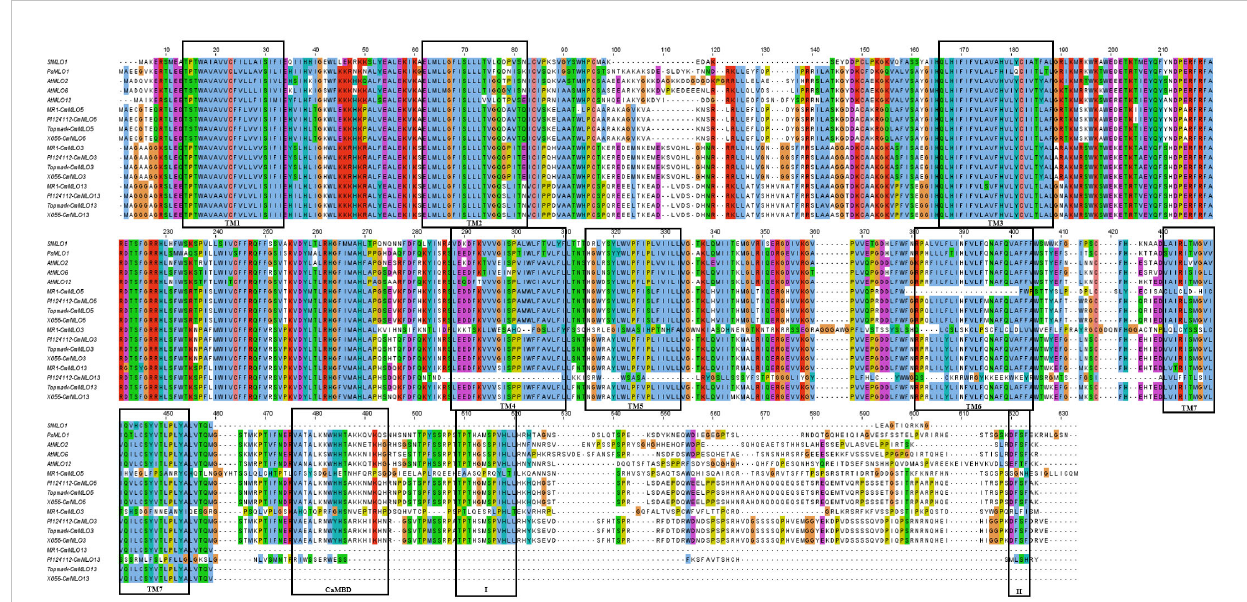
FIGURE 7 Multi-sequence comparison between the CmMLO protein in Clade III and powdery mildew susceptible MLO proteins in PsMLO1, SIMLO1, along with AtMLO2, 6, and 12. TM1 – TM7 is representing seven MLO protein transmembrane domains, and I and II representing two conserved domains in the c-terminal of high polymorphism.